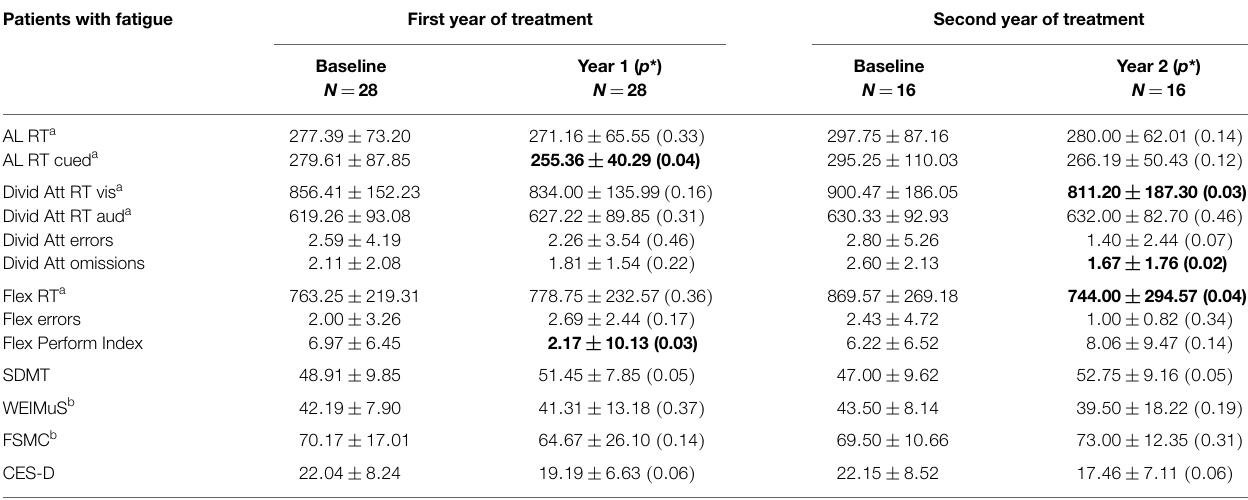
TABLE 4 | Analysis of cognitive parameters from patients with fatigue at baseline . Patients with